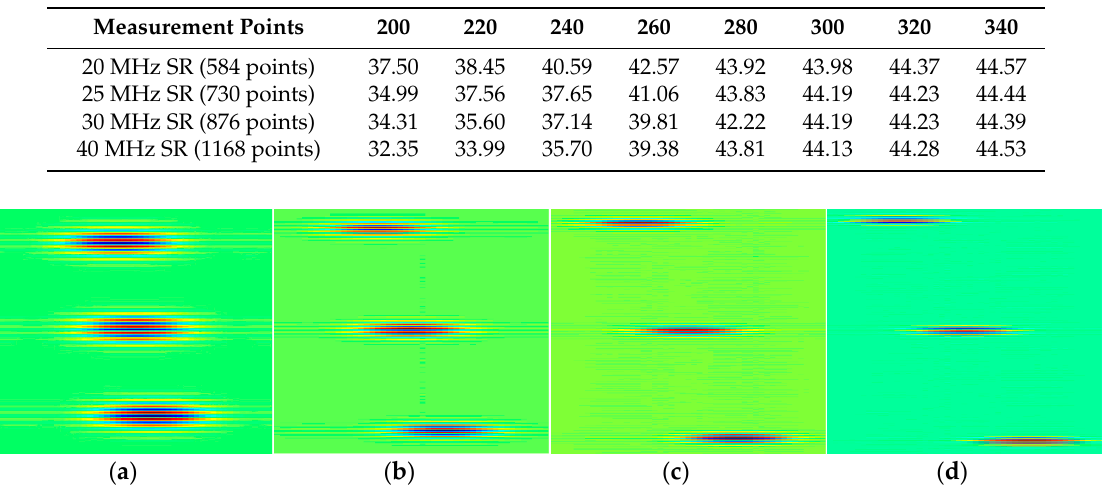
Table 2. Comparative PSNR of different SRs when keeping the same sampling points, using simulated data.